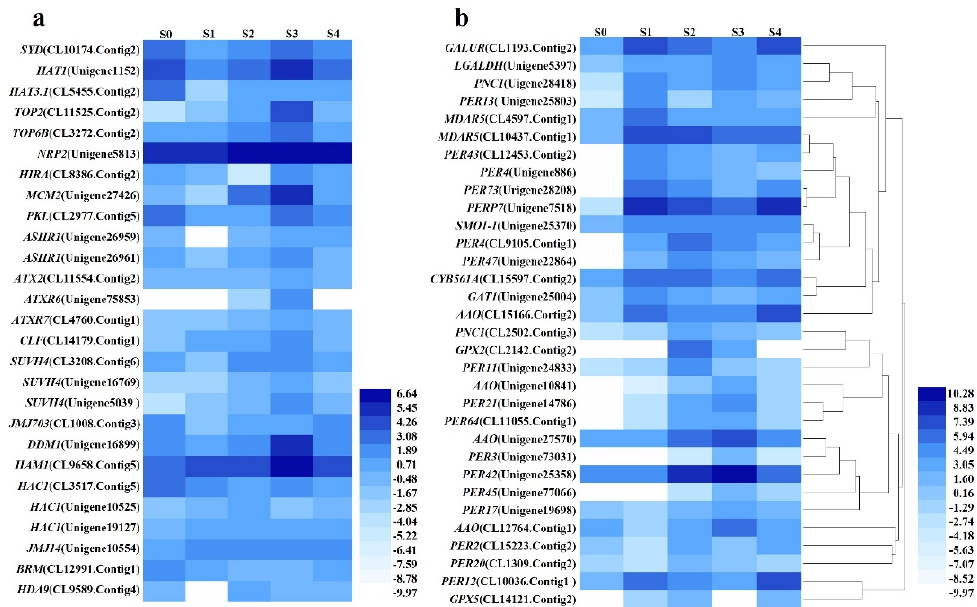
Figure 7. Identification and analysis of the DEGs annotated to the regulation pathways of epigenetic modifications and stress responses. ( a ) Heat maps describing the expression profiles of DEGs related to epigenetic modifications. ( b ) Heat maps describing the expression profiles of DEGs related to stress